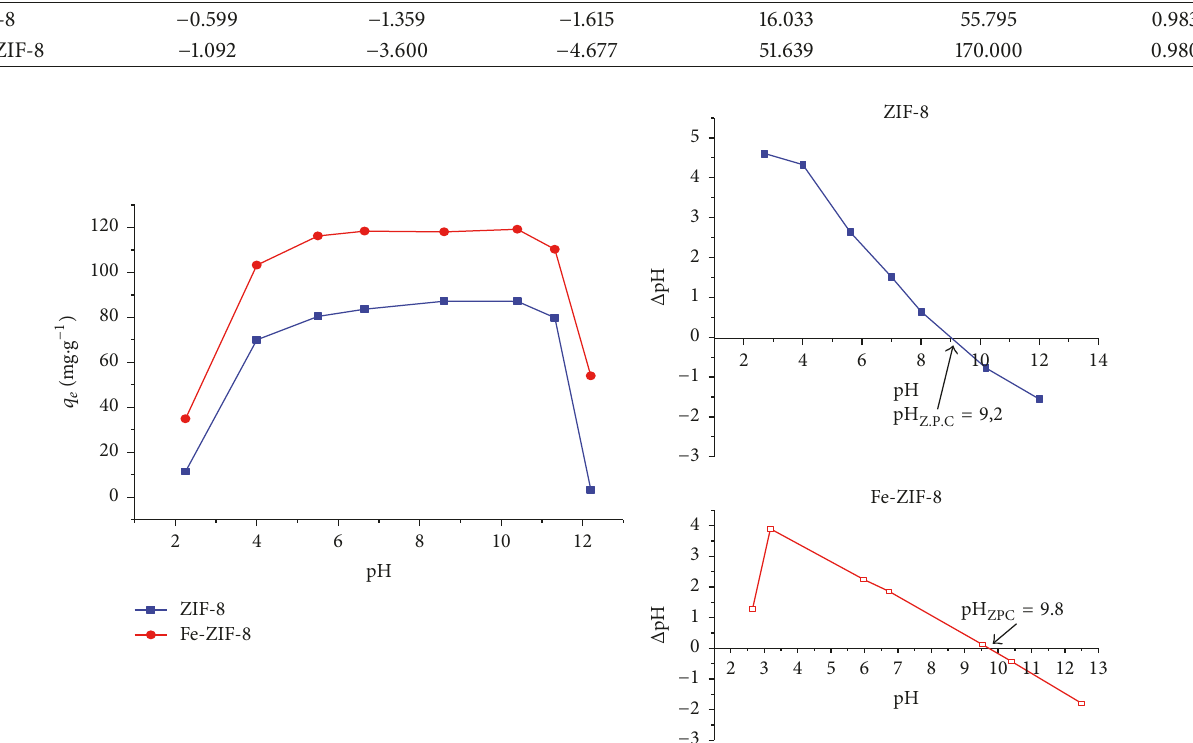
= 50mg ⋅ L −1 ; 𝑚 = 0.02 g; V = 50 mL; shaking time = RDB Adsorbent